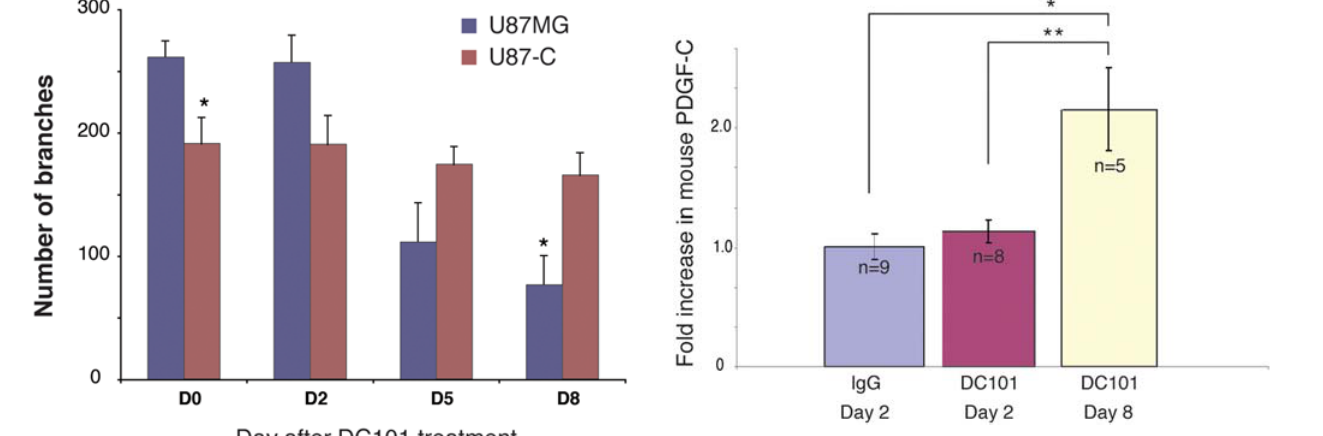
Figure 6. DC101 increases host PDGF-C expression. U87MG tumor-bearing mice were treated with DC101 (40 mg/kg) when their tumors reached 2 mm in diameter. Tumors were harvested and snap- frozen at baseline (n=9), 2 days (n=8) and 8 days (n=5) after initiation of treatment. Day 8 corresponds to the time of escape from DC101 treatment in this model[24]. Quantitative PCR was performed using primers for mouse PDGF-C (forward primer: ACCACGAGTC- CTTCGGTGTT, located at 529 bp; reverse primer: GCATTGTTGAG- CAGGTCCAA, located at 566 bp). At day 8 DC101-treated tumors had significantly more mouse PDGF-C compared to base line and to control, baseline tumors (p , 0.05) IgG-treated animals die before day 8.